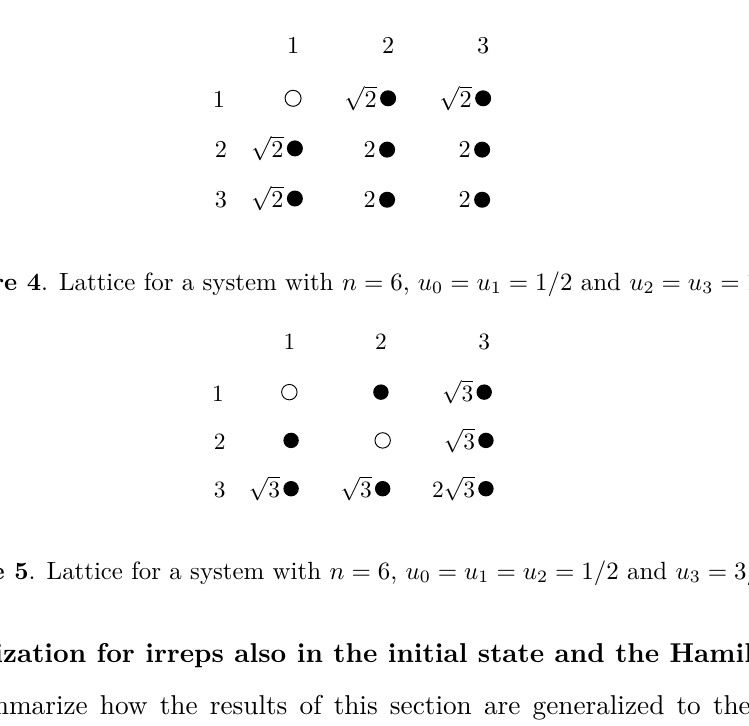
Figure 3 . Lattice for a system with n = 6 , u 0 = u 1 = u 2 = u 3 = 1 / 2 and u 4 = 1 .